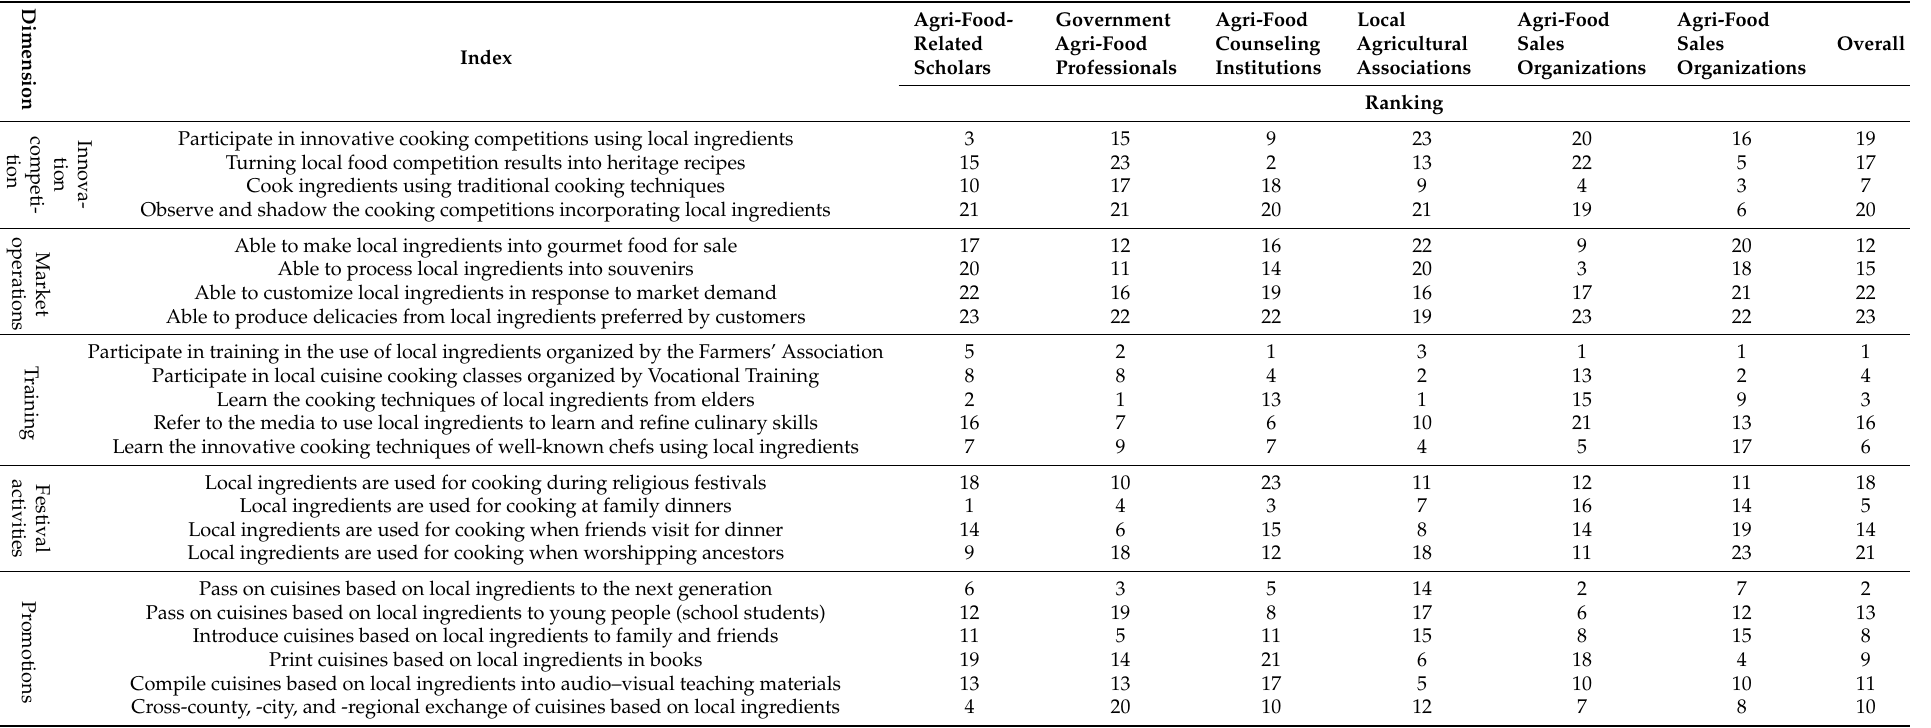
Table 3. Ranking list of indicators of local food culture inheritance and sustainable innovation development by overall